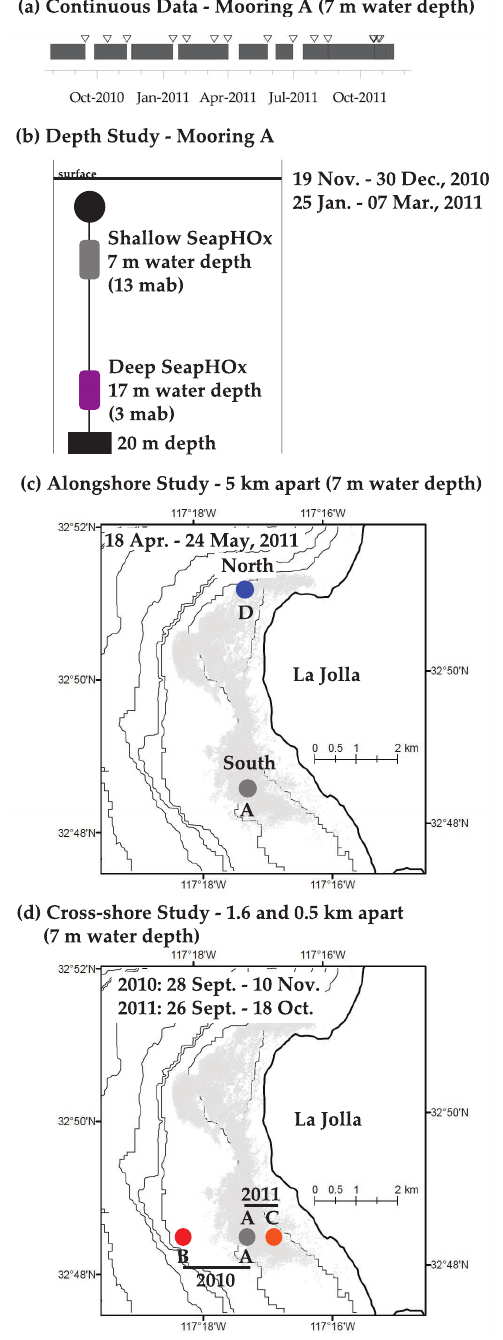
Fig. 1. Placement of SeapHOx sensors among moorings to charac- terize DO and pH differences (a) over time, (b) with depth, (c) in an alongshore direction, and (d) in a cross-shore direction. Bathymet- ric contours are in 10m increments (10–60m depth). At least one discrete sample (upside-down triangles) was taken per SeapHOx deployment to calibrate the pH sensor. Color scheme of moor- ings corresponds with subsequent figures. Grey shading in (c) and (d) depicts maximum extent of the La Jolla Kelp Forest based on aerial surveys from 1989–2009 (California Department of Fish and